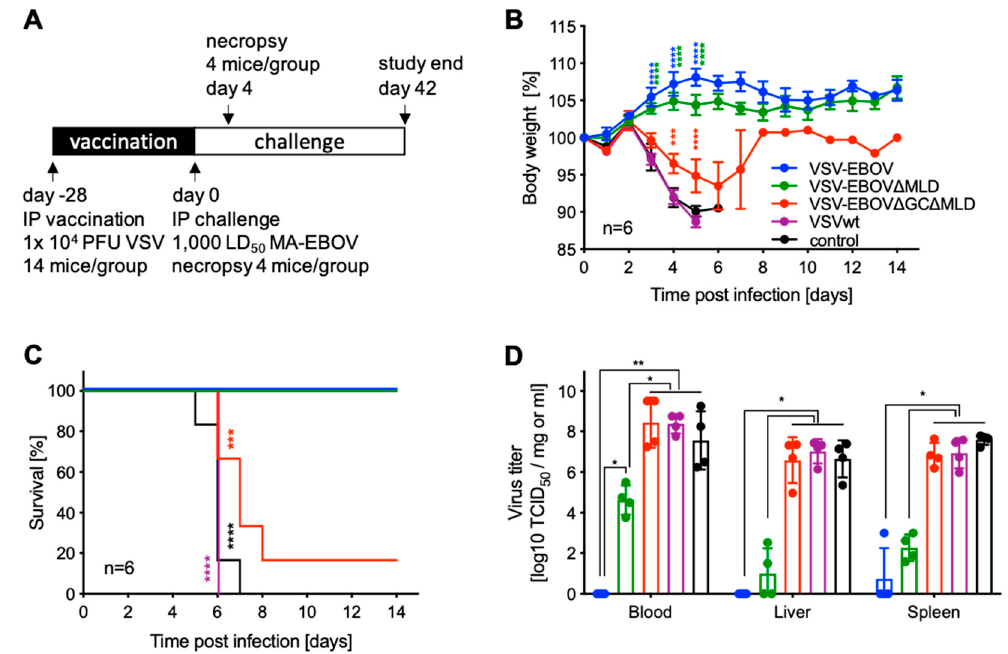
Figure 2. Study outline and protective efficacy in mice. ( A ) Study outline. Groups of CD1 mice were intraperitoneally (IP) vaccinated with a single dose of 1 × 10 4 PFU of the vaccines 28 days prior to lethal challenge. ( B ) Body weight changes and ( C ) survival curves are shown. ( D ) On day 4 after challenge, 4 mice in each group were euthanized for sample collection, and virus titers were determined. Geometric mean and SD are depicted. Statistical significance is indicated as follows p < 0.0001 (****), p < 0.001 (***), p < 0.01 (**), and p < 0.05 (*).